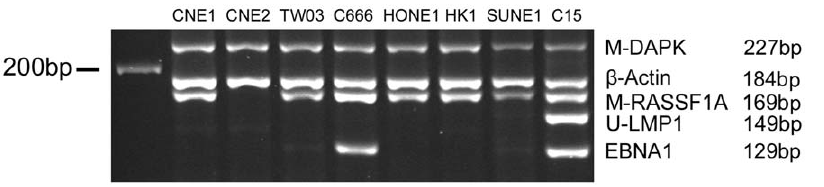
Figure 2. Multiplex Methylation-specific PCR analysis in NPC cell lines and xenograft. All of the cell lines and xenograft showed aberrant methylation on at least one of the two TSGs included in the MMSP assay. The presence of EBV can be only detected in the C666-1 cell line and the EBV-positive xenograft C15. Unmethylated- LMP1 can be only detected in LMP1 expressing xenograft, C15. The other cell lines demonstrated negative bands for EBNA1 and LMP1 markers due to loss of EBV during cell passage. doi:10.1371/journal.pone.0045908.g002 Table 2. Representative MMSP results are shown in Figure 4. All swab samples from NPC patients and noncancerous controls